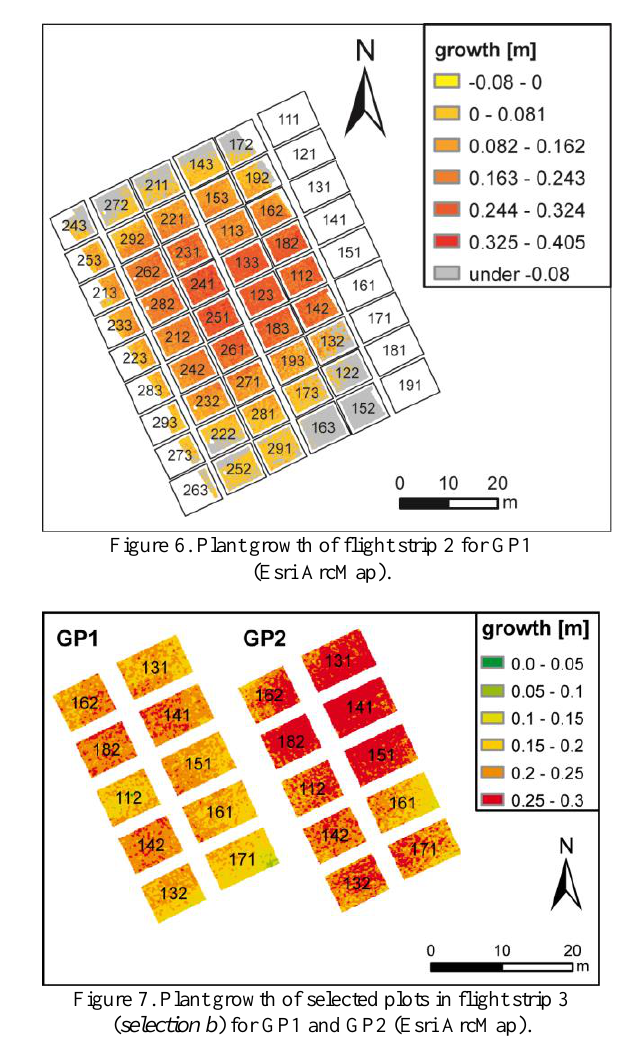
Figure 5. CSM showing flight strip 2 - orange areas indicate high and green areas indicate low heights (09.07.12) (Esri ArcScene, height 2 times exaggerated).